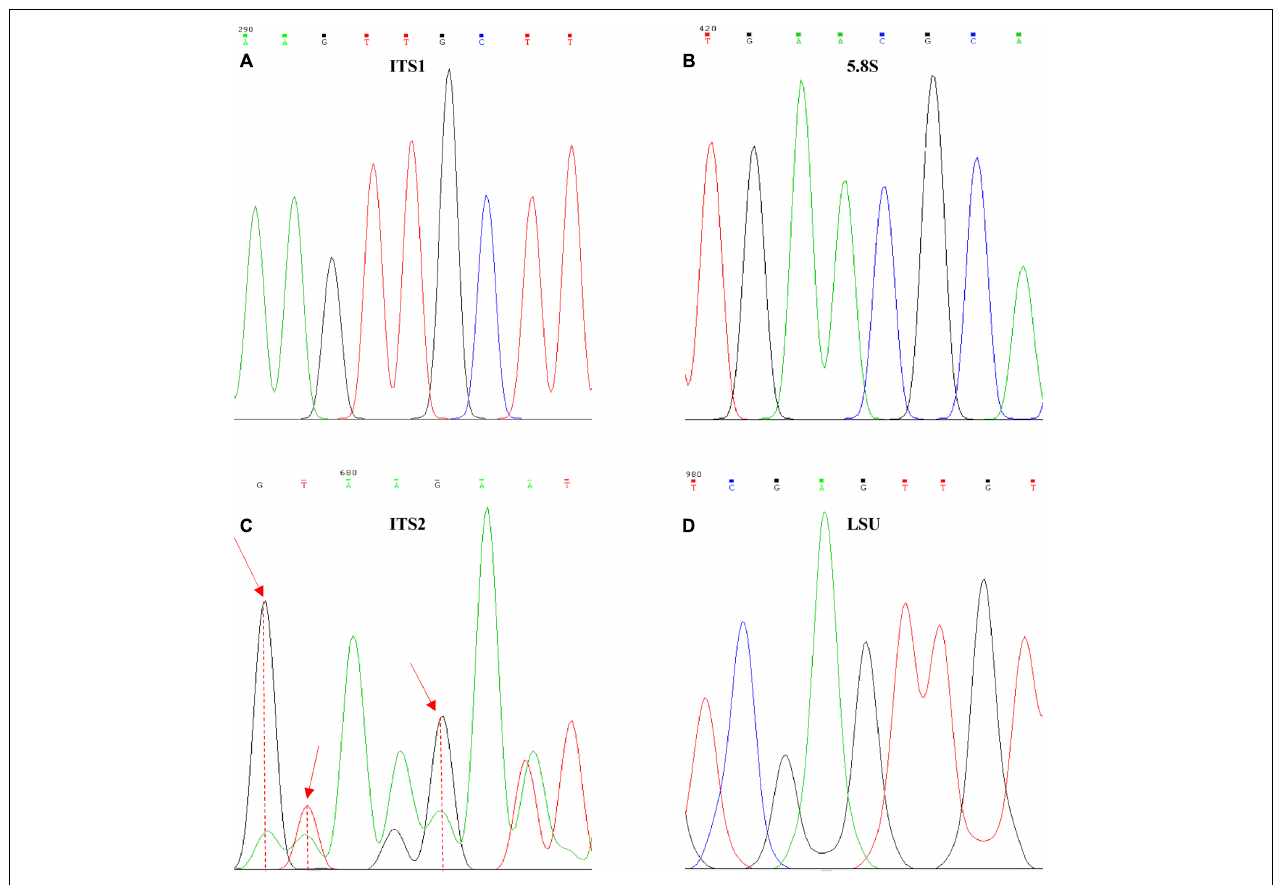
FIGURE 2 | Internal variability on Ogataea uvarum T ITS and LSU sequences. Examples of the variability found in the four barcoding genes, (A) ITS1, (B) 5.8S, (C) ITS2, and (D) LSU. Red arrows identify positions with high variability degree.